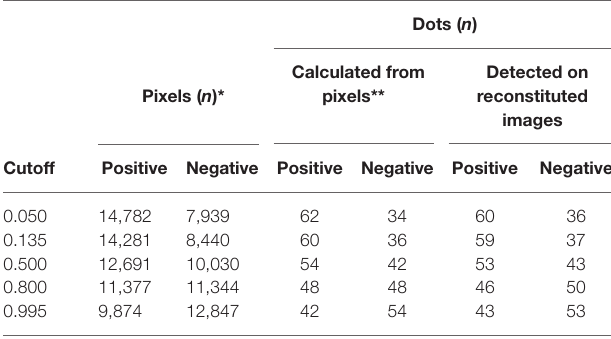
TABLE 4 | Relative numbers of predicted positive and negative pixels of dots of the DE output of unknown samples and the corresponding numbers of dots calculated from pixels or counted in the reconstituted images by increasing cutoff values (related to Figure 8 ). Dots ( n )